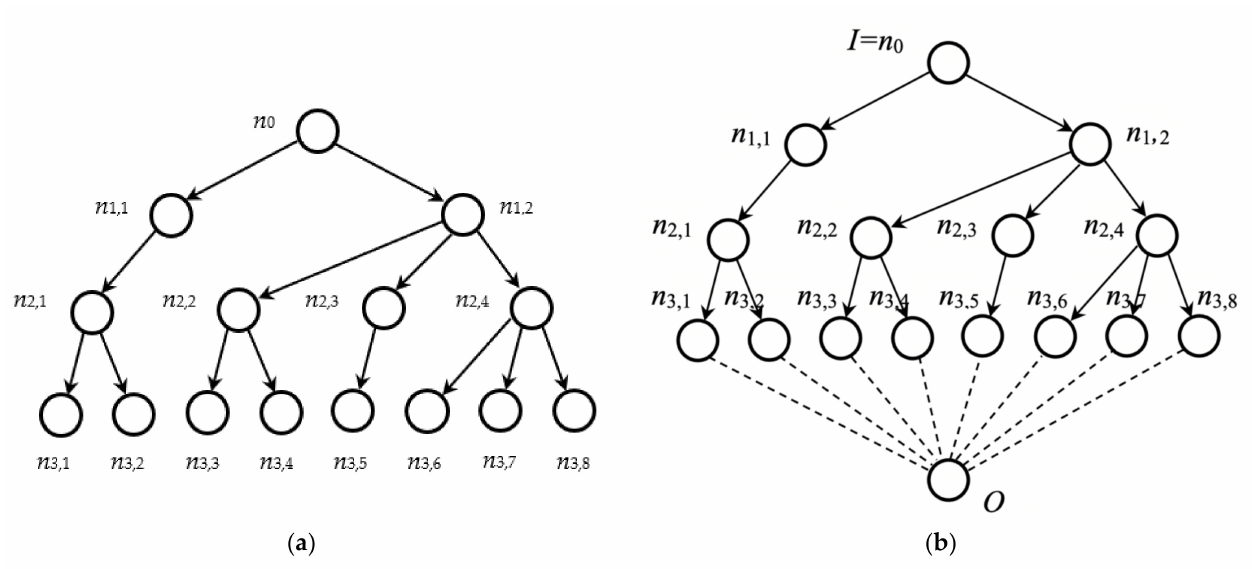
Figure 1. ( a ) A tree data structure example. ( b ) A lattice results in from the tree above by inserting an additional level including the least lattice element O . The tree root corresponds to the greatest lattice element I